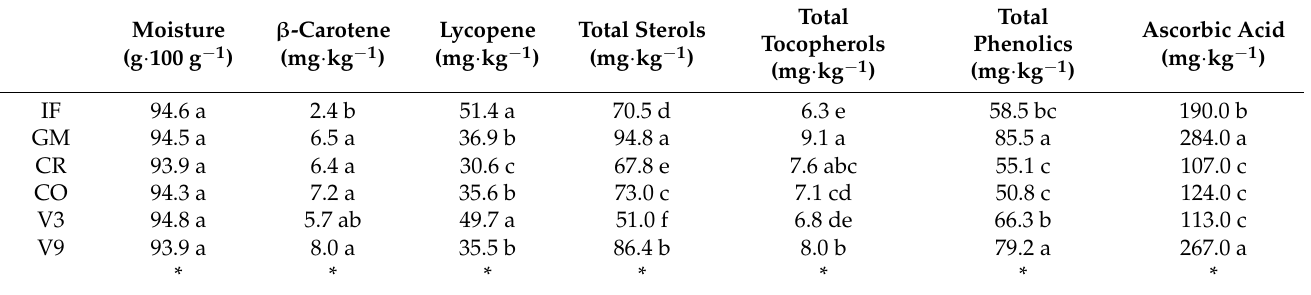
* Different letters in the same column indicate significant differences between treatments according to the LSD test ( p ≤ 0.05); ns: not significant. The a* value indicates the intensity of red colour, and it is related to the lycopene content [35], with higher a* values more desirable in red tomatoes [36]. The a* value was